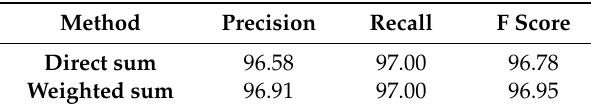
Table 5. Comparison of integration methods.